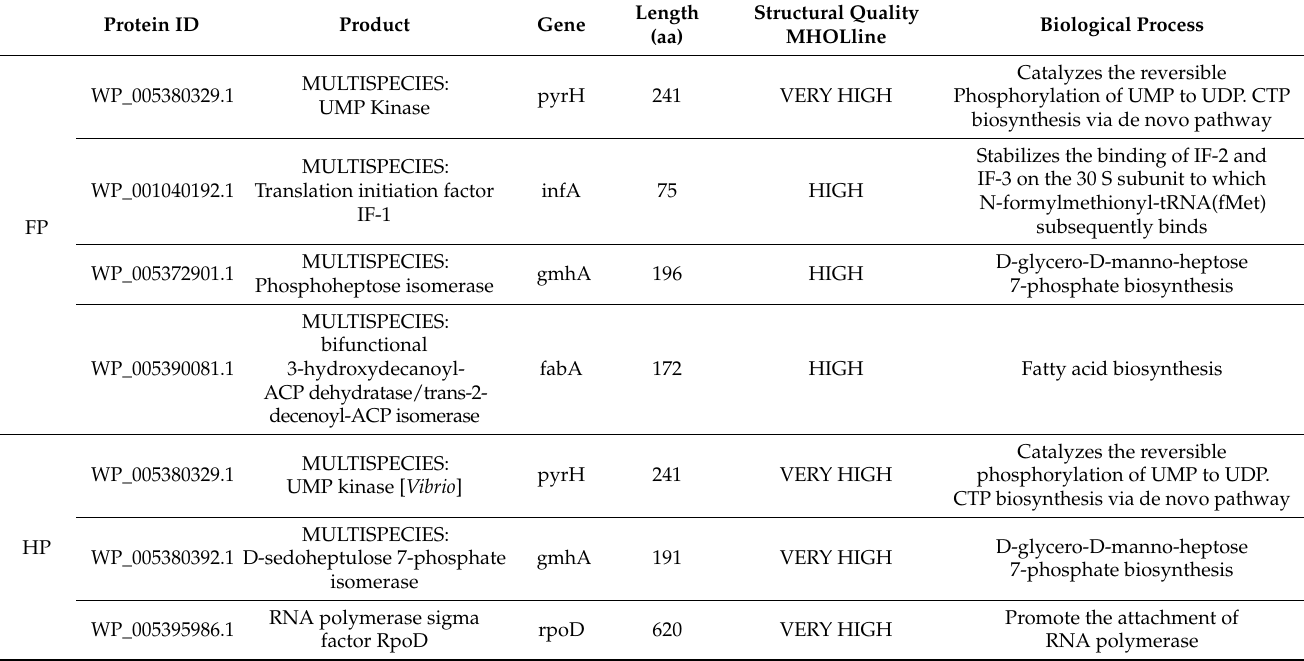
Table 4. Information on drug targets, protein ID, products, genes, sizes (in amino acids), structural quality by MHOLline 2, and the respective biological processes retrieved from Uniprot.